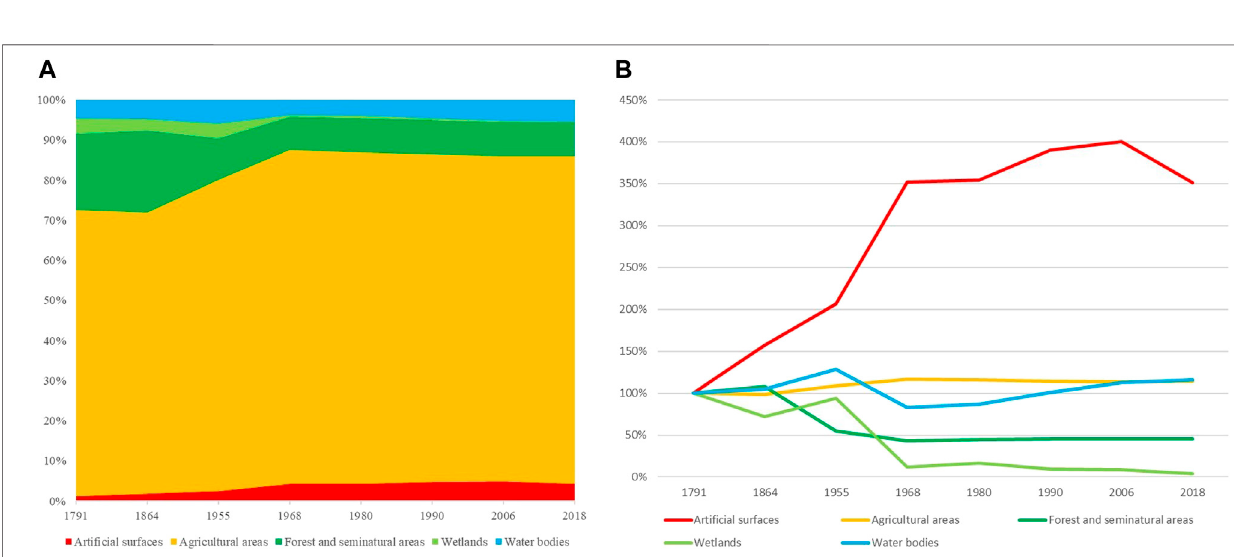
Frontiers in Environmental Science |